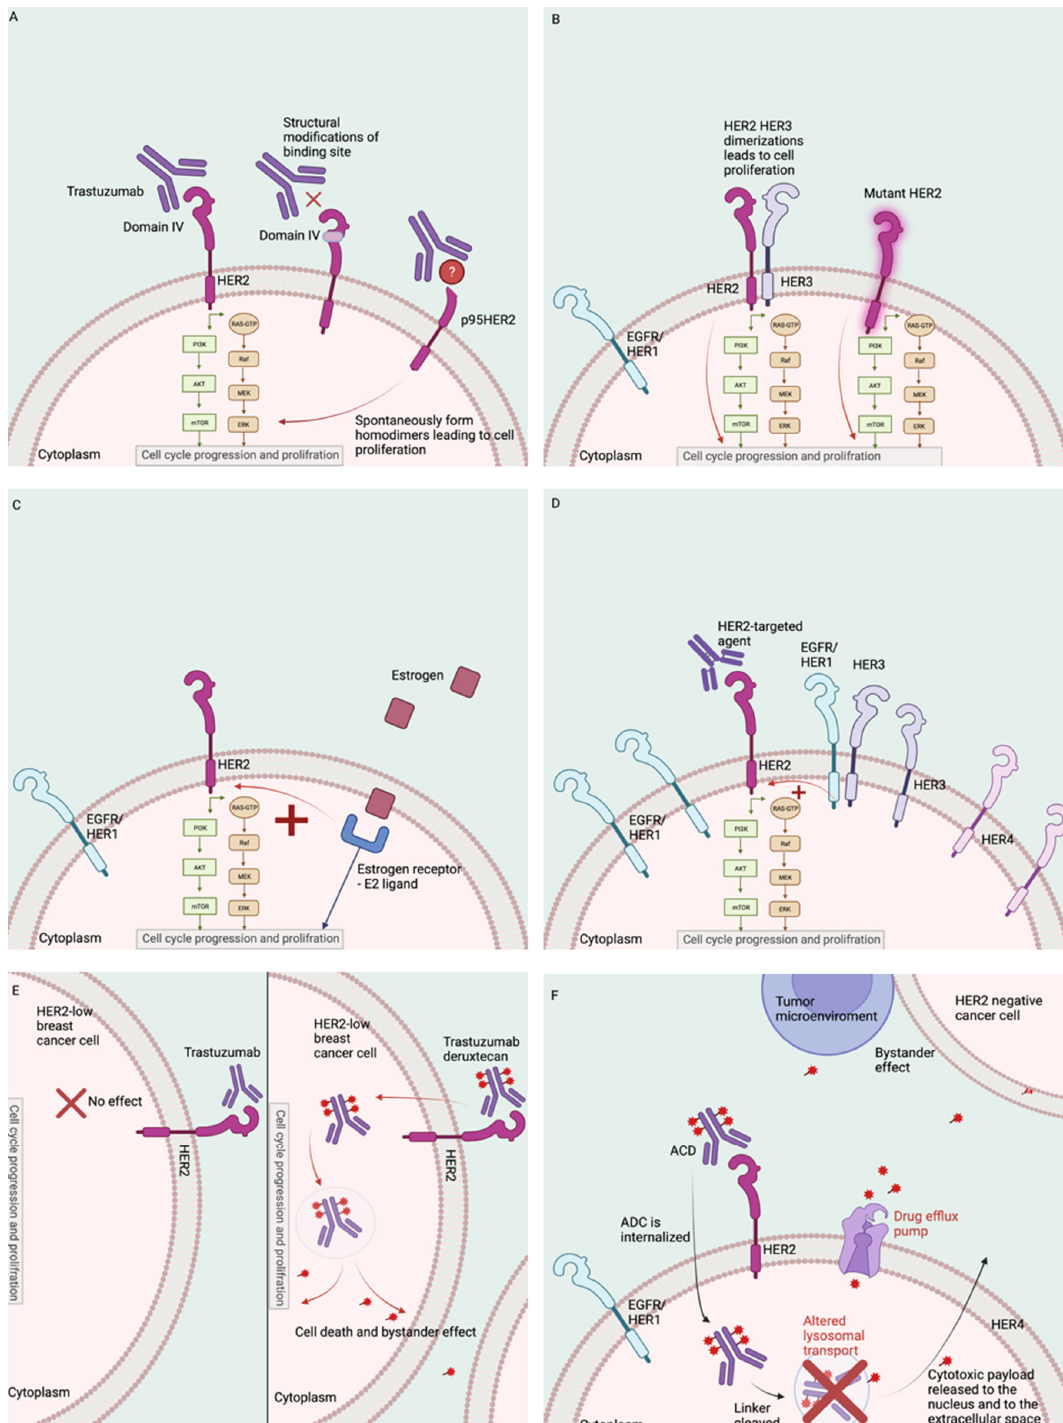
Figure 2. Mechanisms of resistance to HER2-targeted agents. Legend: ( A ) structural modifications of the monoclonal antibody binding site; ( B ) activating mutations in the HER2/ERBB2 gene; ( C ) cross-talk between HER2 and estrogen receptors; ( D ) increased expression of EGFR and HER3. ( E ) The level of HER2 expression can impact response to certain HER2-targeted therapies; this figure shows that HER2-low tumors do not usually respond to monoclonal antibodies but can respond to antibody-drug conjugates. ( F ) Increased activity and expression of the drug efflux pump and altered lysosomal transport are unique mechanisms of resistance to antibody-drug conjugates.